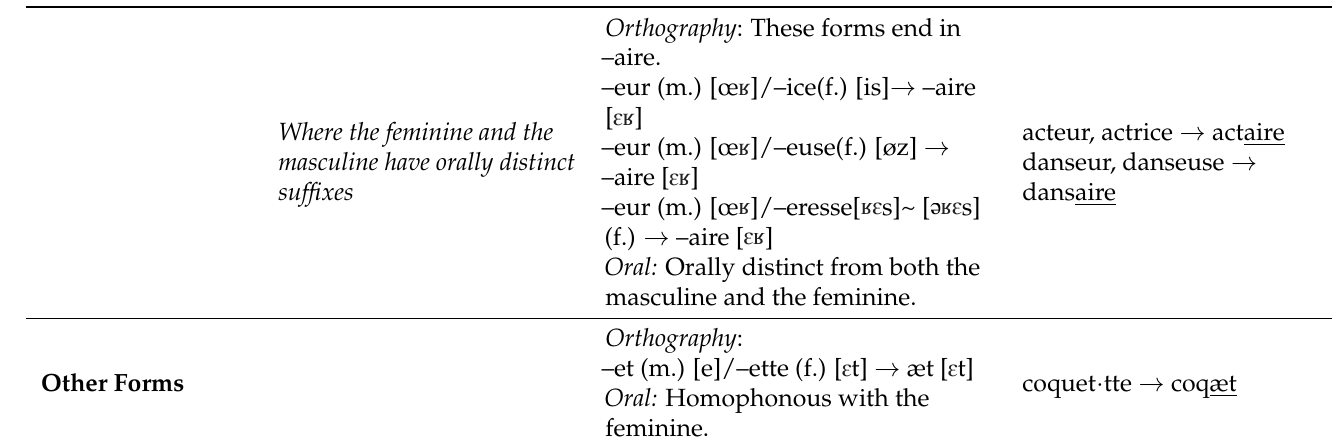
Table 2. Masculine and Feminine Homophones.